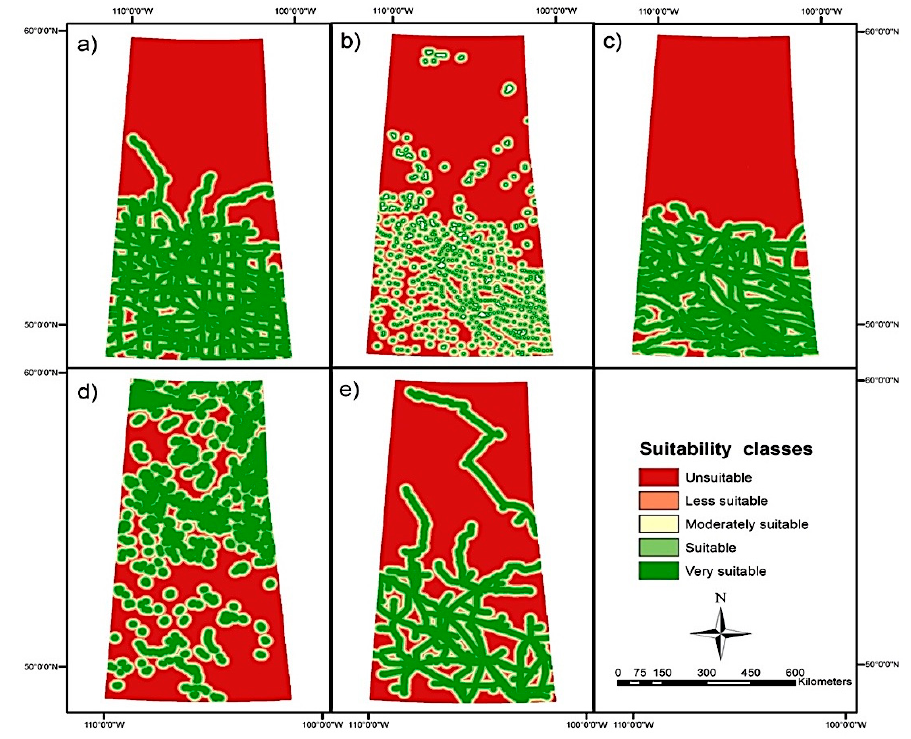
Figure 5. Evaluation criteria maps: ( a ) Highways, ( b ) populated areas, ( c ) railways, ( d ) surface water, and ( e ) transmission lines .